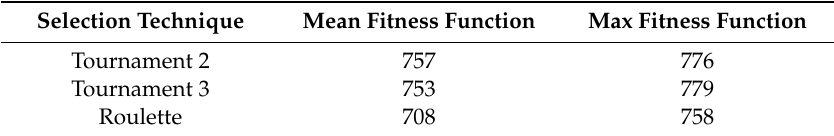
Table 2. Selection technique analysis. Mean and maximum fitness function values in Scenario 2 for Tournament 2, Tournament 3, and Roulette.